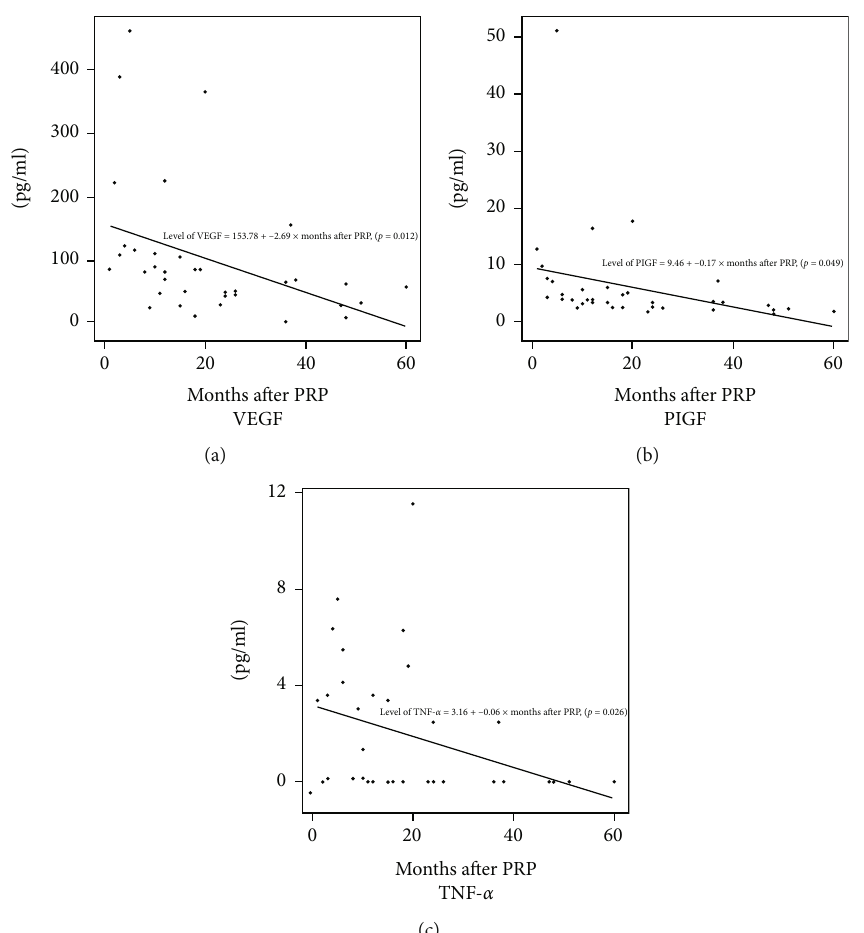
Figure 2: Univariate linear regression analyses by the aqueous levels of (a) VEGF, (b) PlGF, and (c) TNF- α by the interval between PRP and aqueous sampling. All levels were signi fi cantly negatively correlated with an increasing interval. VEGF: vascular endothelial growth factor; PlGF: placental growth factor; TNF: tumor necrosis factor; PRP: panretinal